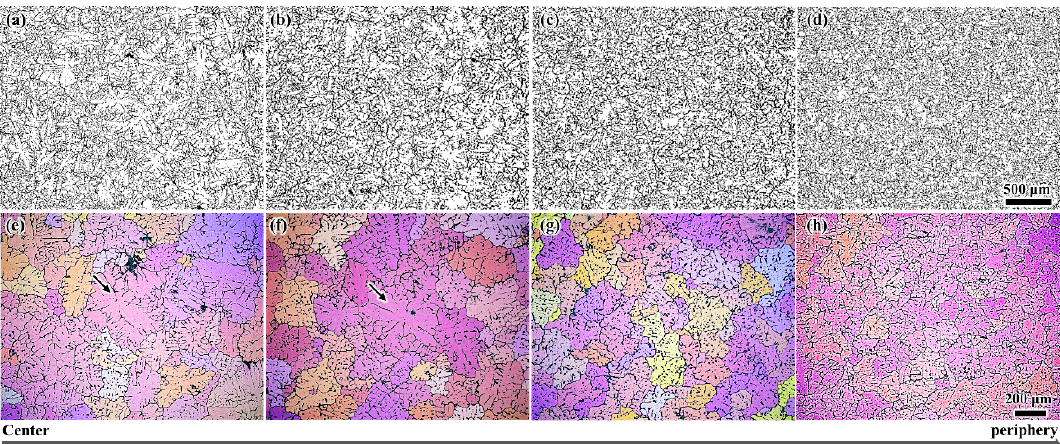
Figure 4. Typical microstructural results of the DC cast billet from center to the periphery for different distances from billet center ( a ) and ( e ) 0 mm, ( b ) and ( f ) 20 mm, ( c ) and ( g ) 40 mm, ( d ) and ( h ) 60 mm. Materials 2020 , 13 , x FOR PEER REVIEW